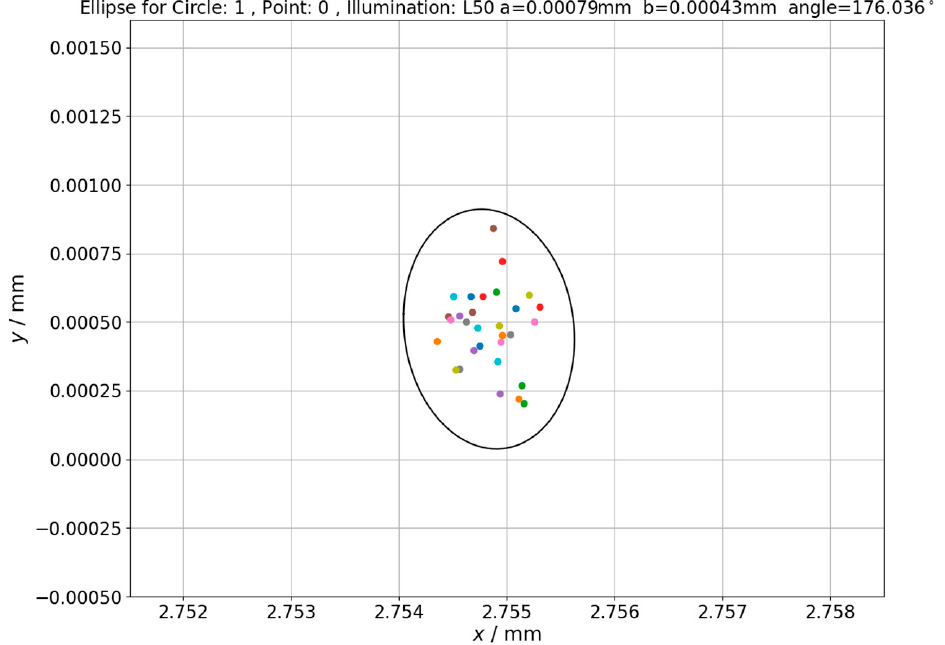
Figure 11. The ellipse of point repeatability obtained for first point in measurement routine. Hole plate standard measurements—Circle 1. Applied illumination L50.